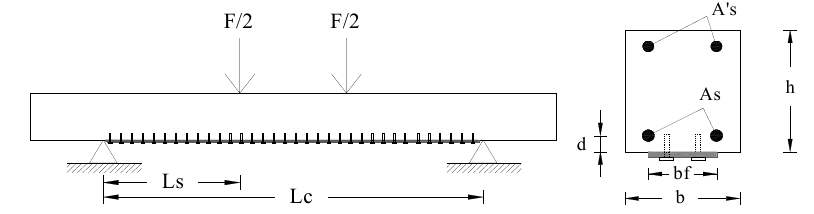
Figure 7. The configuration of four point-bending tests collected from the literature.